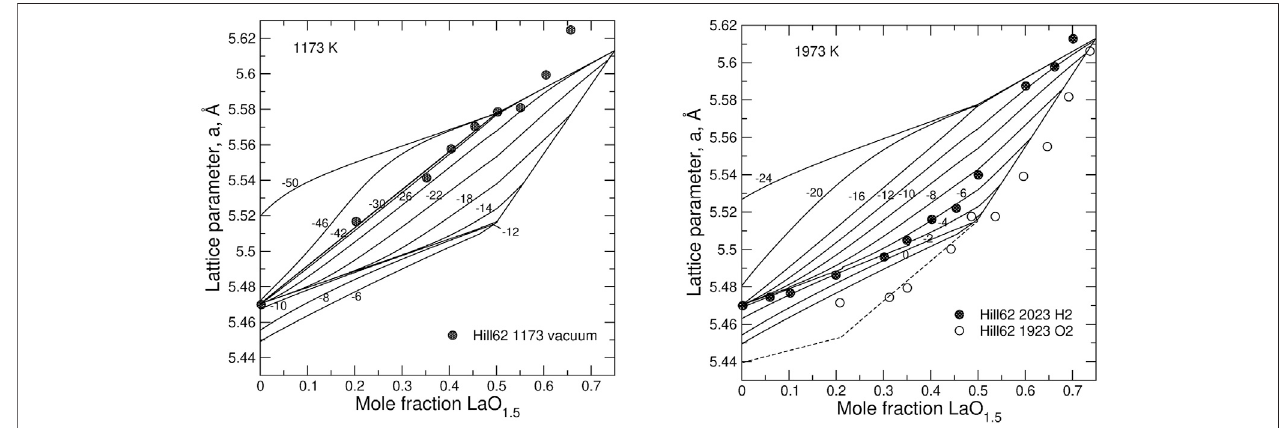
FIGURE9| Relationshipbetweenthelatticeparameterandthedegreeofdoping, z ,inLaO 1.5 – UO 2 systempredictedfromthemodel.Theexperimentaldataseries from Hill (Hill, 1962) are interpreted to be synthesized at – 42 < log (cid:1) P O possibly indicate the need of including U +6 states into the